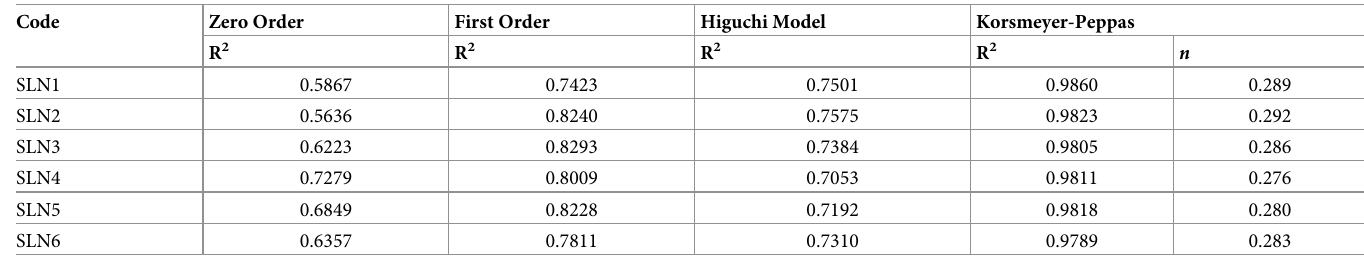
Table 2. Kinetic modeling of 5-FU-loaded SLNs.